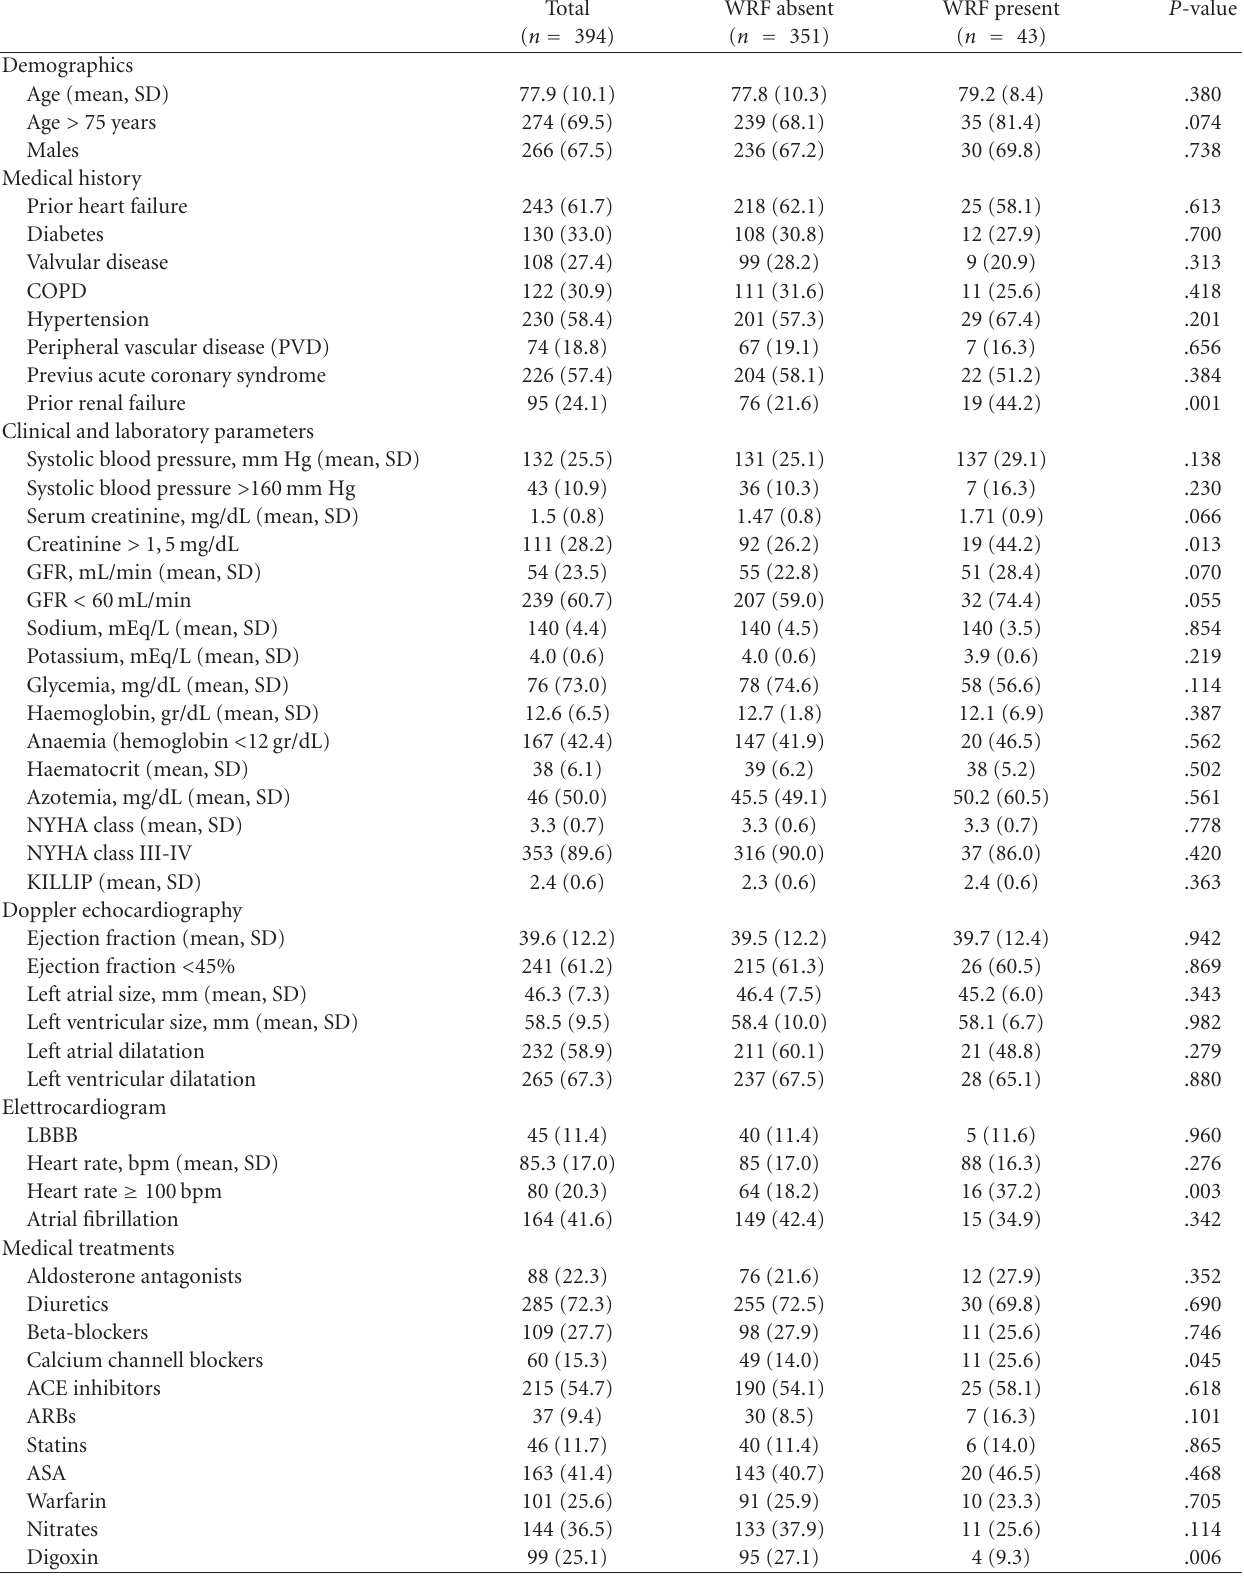
Table 1: Characteristics at admission of the whole population and of patients with and without WRF